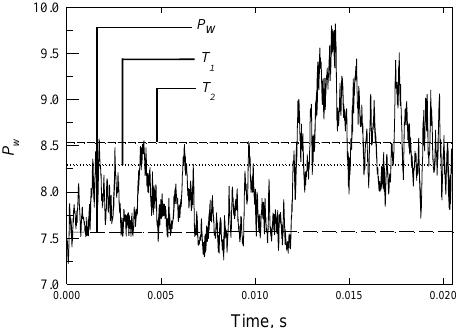
Figure 10. A sketch for two-threshold method.